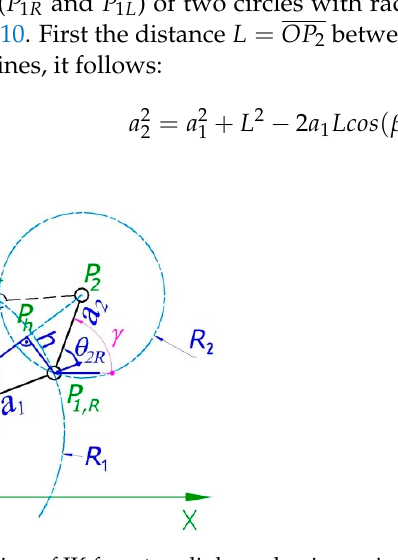
Figure 10. Determination of IK for a two-link mechanism using a geometric approach.